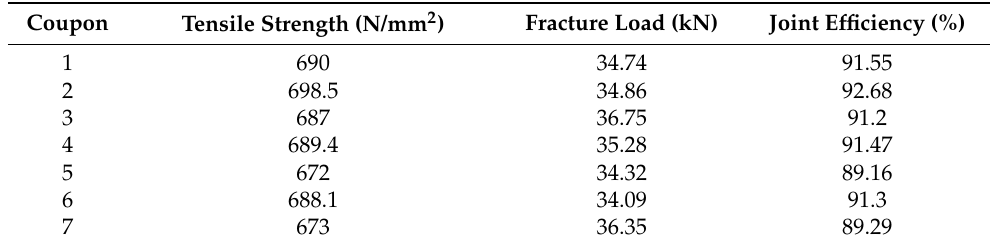
Table 5. Values obtained in the tensile testing for tensile strength, fracture load, and joint efficiency for welding coupons. Coupon Tensile Strength (N/mm 2 ) Fracture Load (kN) Joint Efficiency (%) 1 690 34.74 91.55 2 698.5 34.86 92.68 3 687 36.75 91.2 4 689.4 35.28 91.47 672